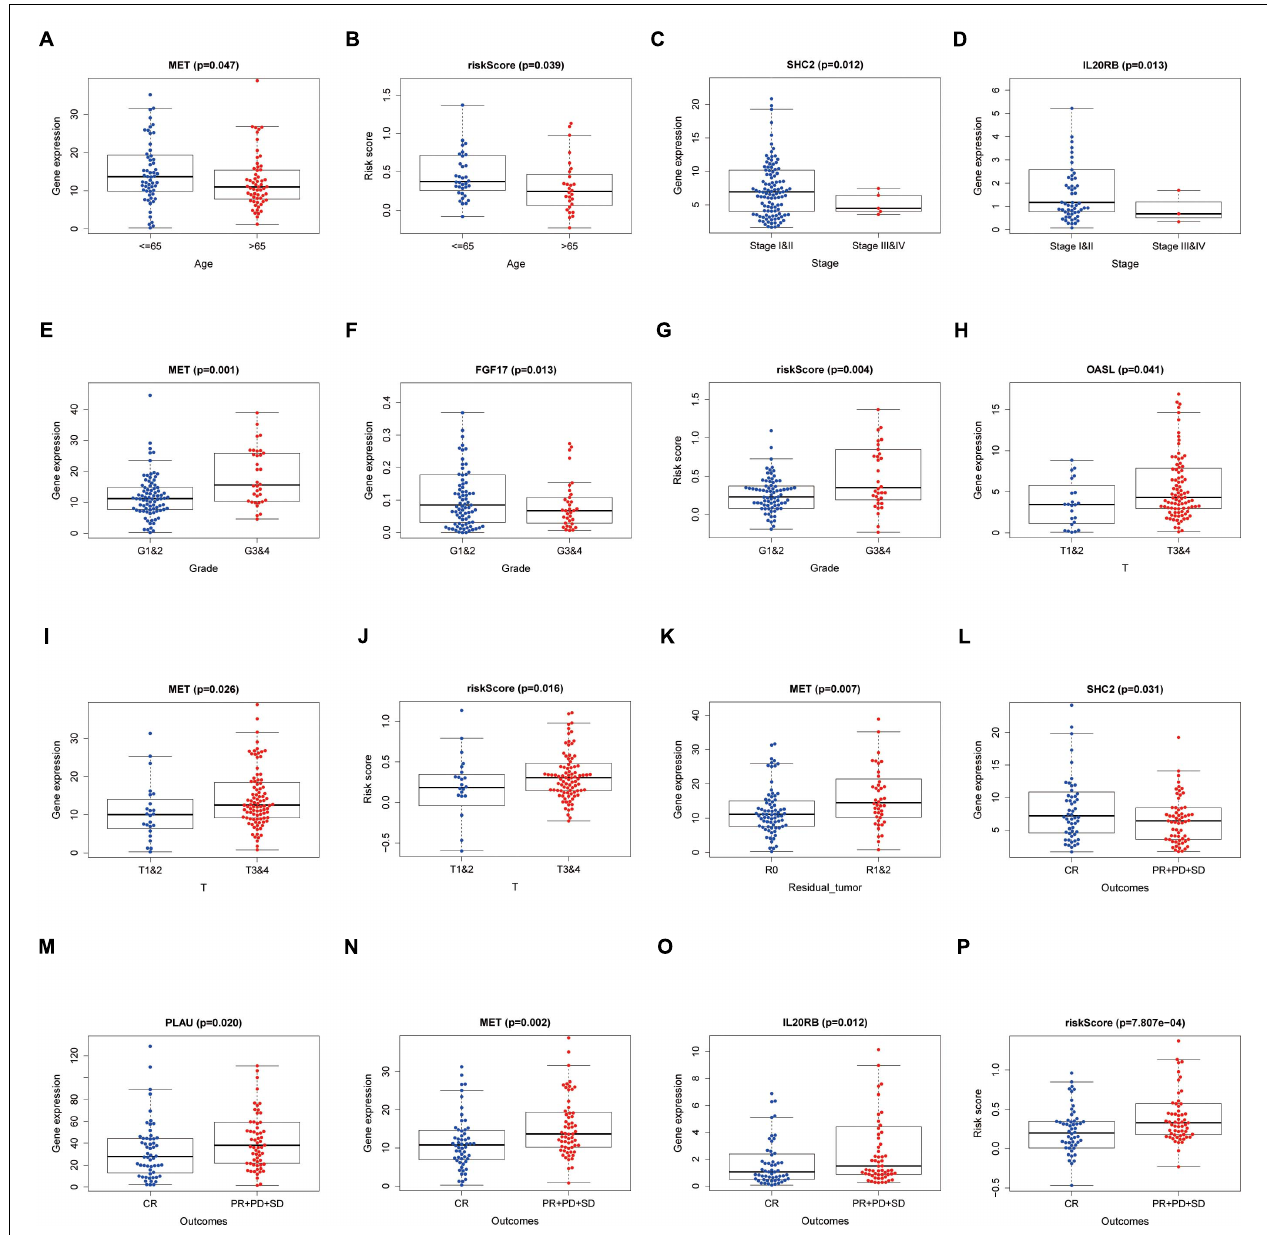
FIGURE 8 | Relationships between the clinical-pathological characteristics and expression of DEIRGs in PAAD. (A) Differences in expression of DEIRGs between the pathological TNM stages I and II/III and IV in PAAD. (B,C) Differences in expression of DEIRGs between the histology G1 and 2/G3 and 4 grades in PAAD. (D,E) Differences in expression of DEIRGs between the T stages T1 and 2/T3 and 4 in PAAD. (F–K) Differences in expression of DEIRGs between the M stages M0/M1/MX in PAAD. (L) Differences in expression of DEIRGs between the residual tumor R0/R1 and R2 in PAAD. (M–P) Differences in expression of DEIRGs between the outcomes (CR/PR + PD + SD) in